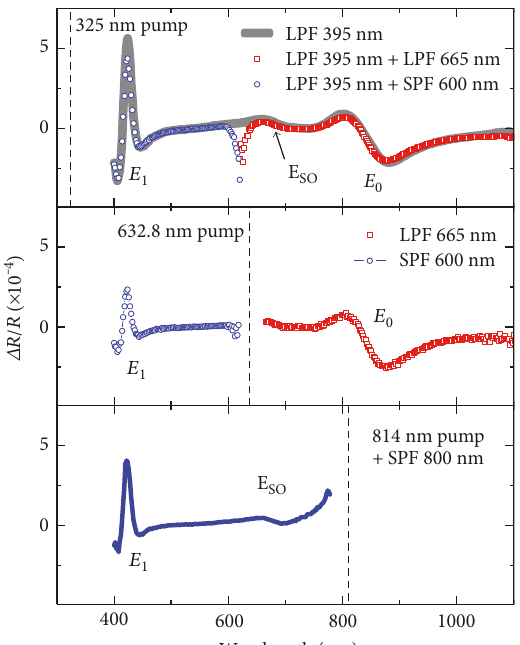
Figure 2: PR spectra of n -GaAs wafer obtained under di ff erent pump beam energies and pass fi lters. Dotted lines indicate the nominal wavelength of the pump beams. Critical points E (labeled as E ), and E are also indicated. (Upper panel) using SO 1 325 nm pump with LPF 395 nm and additional LPF 665 nm or SPF 600 nm. (Middle panel) using 632.8 nm pump with LPF 665 nm or SPF 600 nm. (Lower panel) using 814nm pump and SPF